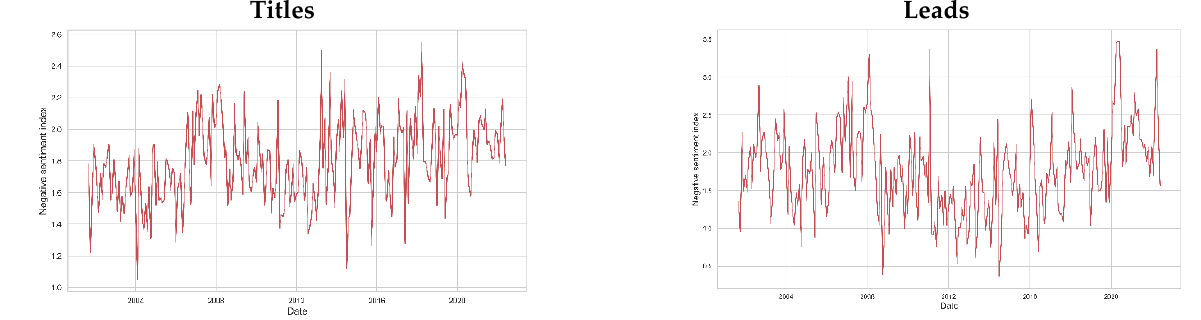
Figure A4. Sentiment analysis of news titles and leads over time for category “ Science ” news.